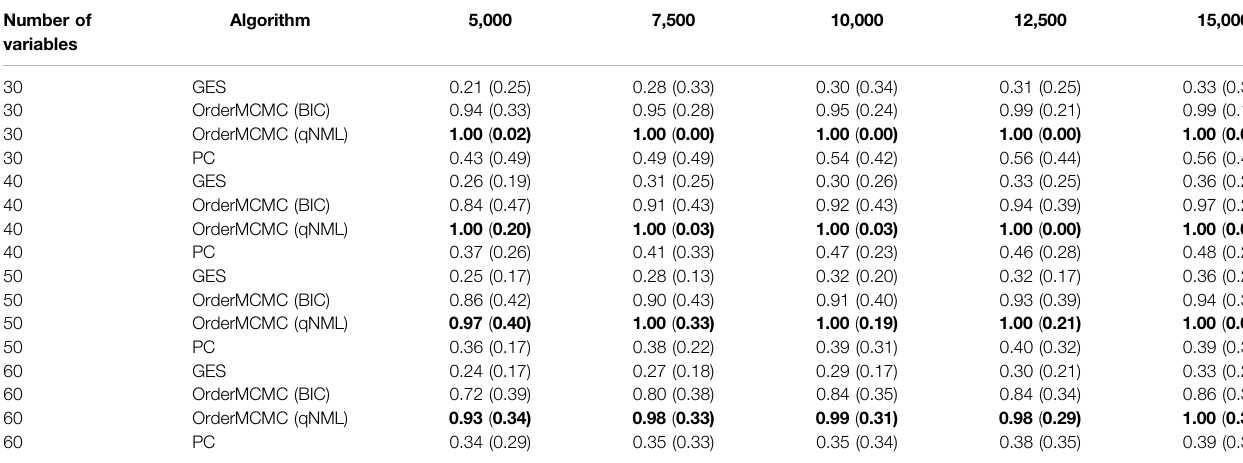
TABLE 5 | Pivot Table of V-structure recall. Rows stratify by number of variables. Columns are over samples size. V-structure Recall performance is provided as: Median (IQR) . Highest recall in each sample/variable combination is in bold. Number of variables